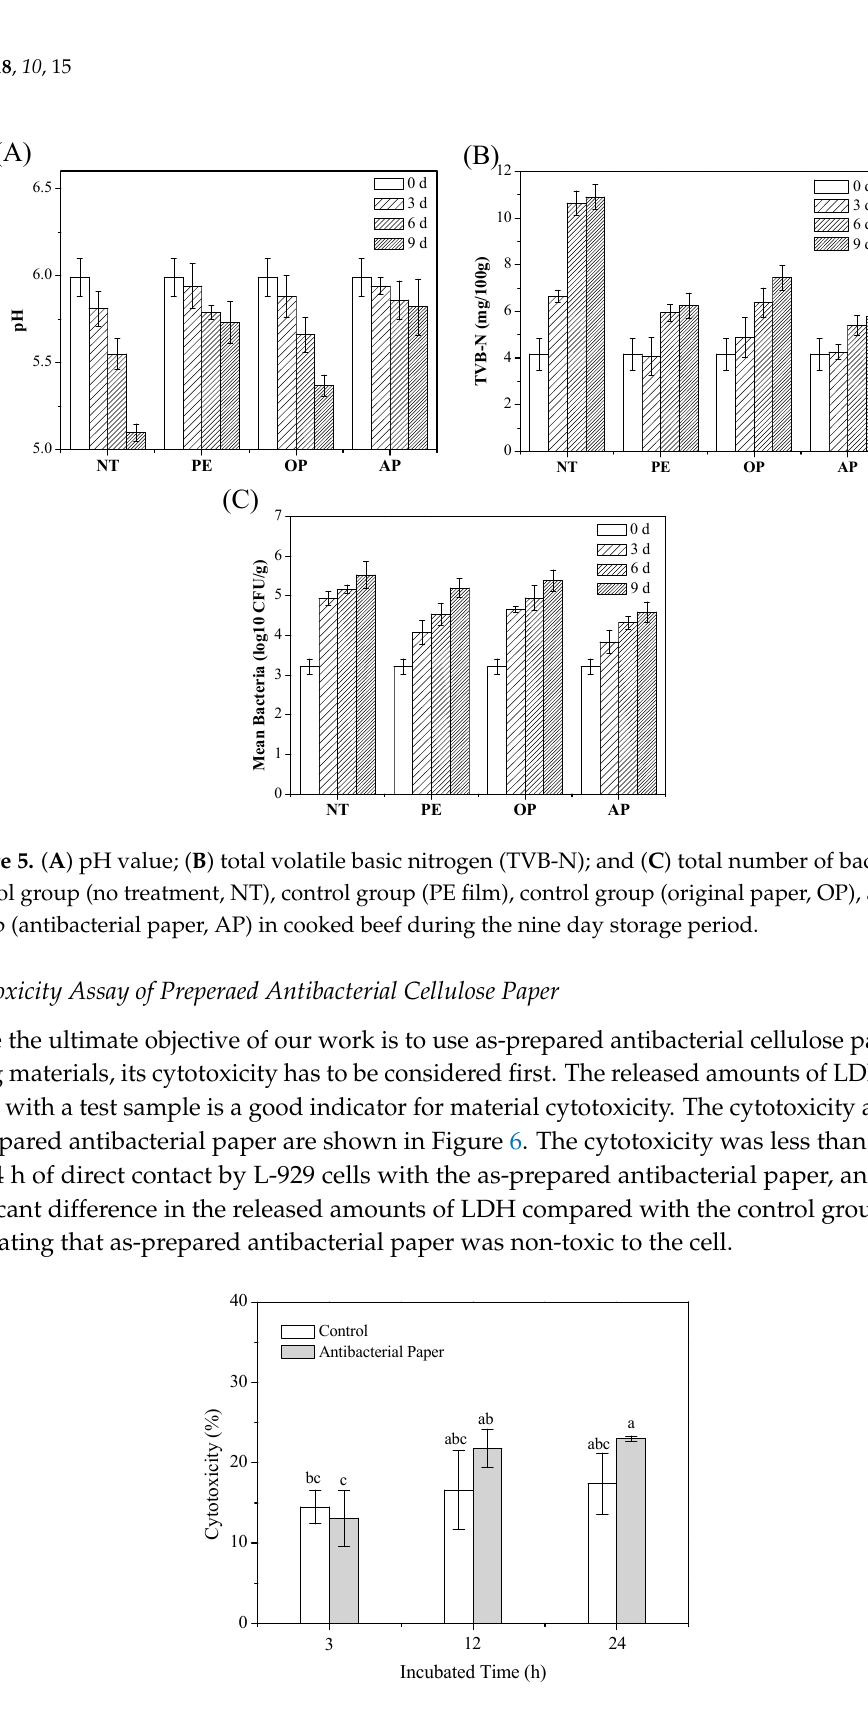
Figure 6. Cytotoxicity of as-prepared antibacterial paper. Values are expressed as the mean ± standard deviation, n = 6. Statistical analysis were performed by using the SPSS 22.0 software package (IBM Corporation, Armonk, NY, USA) and the significant differences were determined using one-way analysis of variance followed by Ducan’s multiple range test with a significance level p <